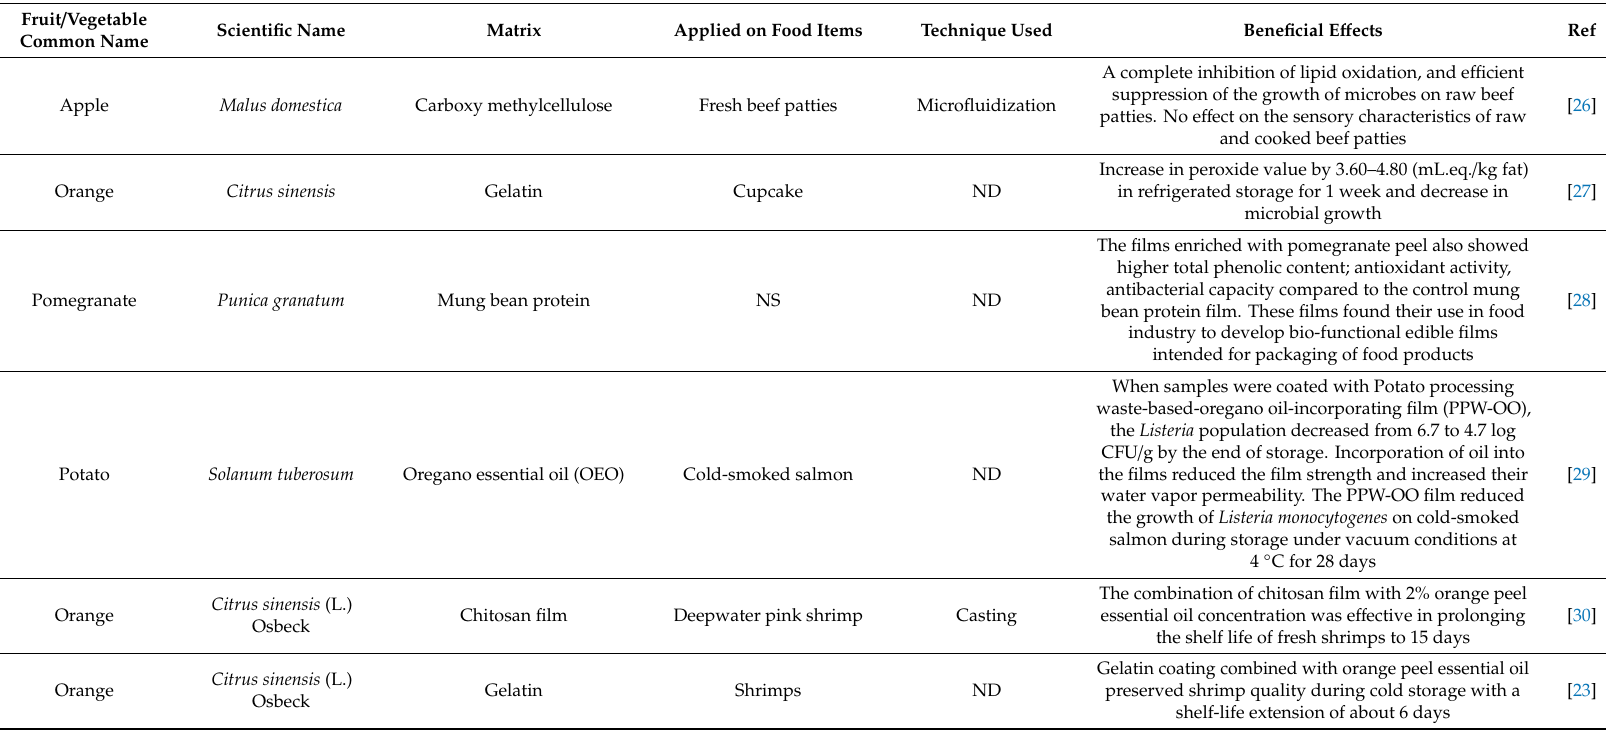
Table 1. Fruits and vegetables peel based edible films / coating with their